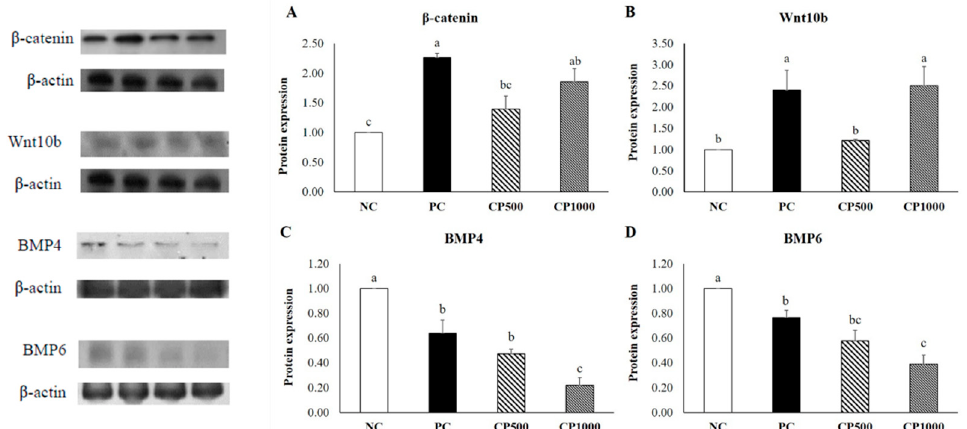
Figure 7. Results of Western blot analyses. Effect of CP on depilation-induced C57BL/6 mice. ( A ) β - catenin; ( B ) Wnt10b; ( C ) BMP4; ( D ) BMP6. Values with different superscript letters are significantly different ( p < 0.05). The results are reported as mean ± SE ( n = 8/group). NC: negative control (distilled water), PC: positive control (finasteride, 1 mg/kg); CP500: collagen peptide, 500 mg/kg; CP1000: collagen peptide, 1000 mg/kg.